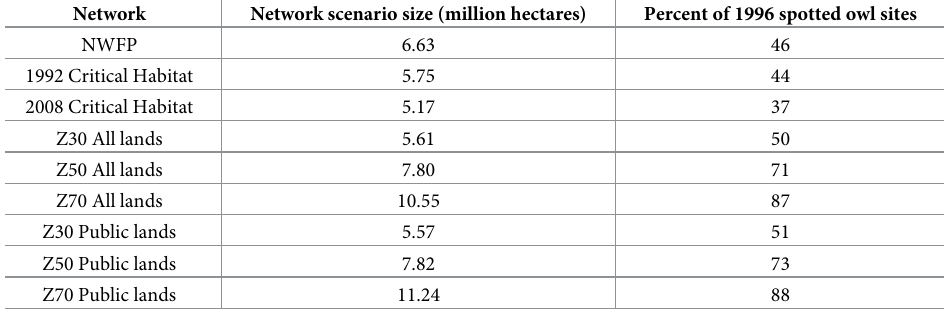
We also include the Northwest Forest Plan (NWFP), and critical habitat designated in 1992 and 2008 for comparison. Z = Zonation-derived networks. The number after Z represents the percentage of habitat value and ALL = no prioritization of lands included, whereas PUB = public lands were prioritized and non-public lands were only included if the goal could not be met with public